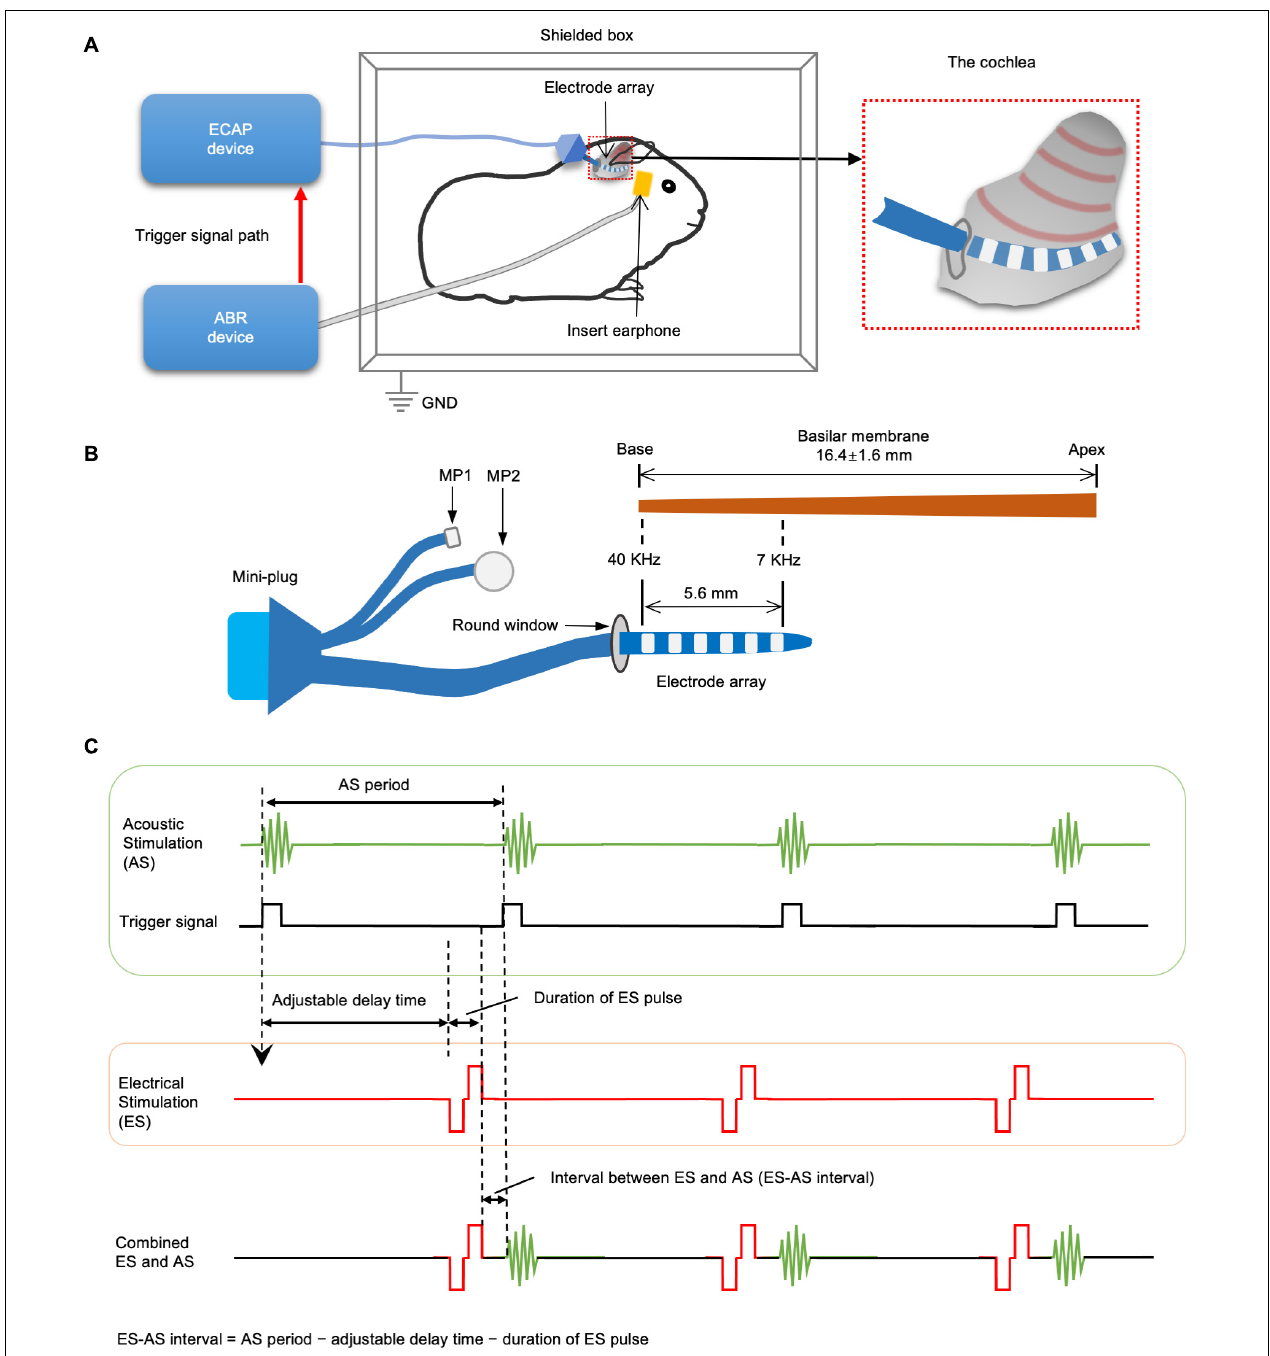
FIGURE 1 | The schematics of combined electric-acoustic stimulation and intracochlear electrocochleography (iECochG) detecting system. (A) The guinea pigs were settled in an acoustic and electromagnetic shielding box. ABR recording device delivers acoustic stimulation (AS) through an insert earphone in the external auditory canal. Meanwhile, it delivers trigger signals to a device detecting electrically evoked compound action potential (ECAP) and iECochG. (B) The ECAP/iECochG device then delivers electrical stimulation (ES) and records iECochG through electrode array in scala tympani. The intracochlear electrode array has six ring electrodes and connects with the ECAP/iECochG device by a mini-plug and two extracochlear electrodes. The most apical electrode is around 7 kHz frequency site of basilar membrane, while the most basal one is around 40 kHz frequency site. (C) The interval between ES and AS (ES-AS interval) can be set by adjusting the delay time between the onset of trigger signal and that of ES. ES-AS interval can be calculated by subtracting the adjustable delay time and ES pulse duration from AS period.